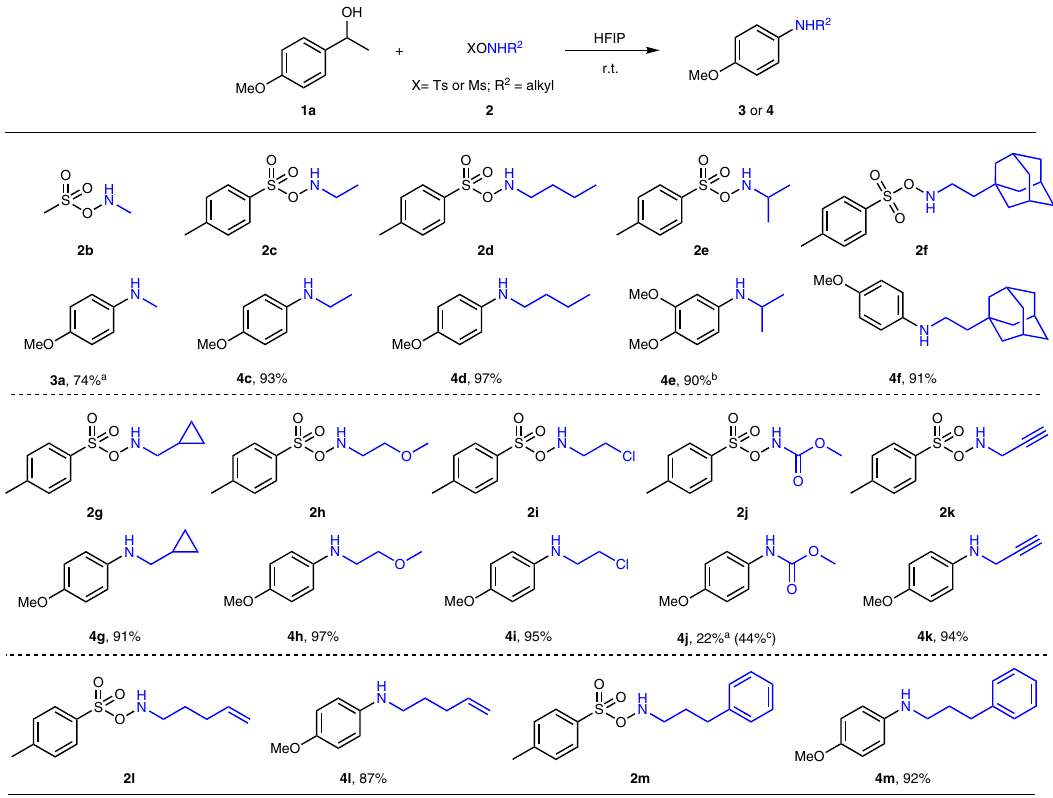
Fig. 3 Scope with regard to the hydroxylamines in the synthesis of secondary anilines. Reaction conditions: alcohol (0.2 mmol), aminating reagents (0.3 mmol), HFIP (hexa fl uoroisopropanol) (1 mL), 12 h, r.t.; a 2b (0.22 mmol); b 1-(3,4-dimethoxyphenyl)ethan-1-ol ( 1ah , 0.2 mmol) instead of 1a ; c TFE (tri fl uoroethanol) (1 mL) instead of HFIP; Ts toluenesulfonyl, Ms